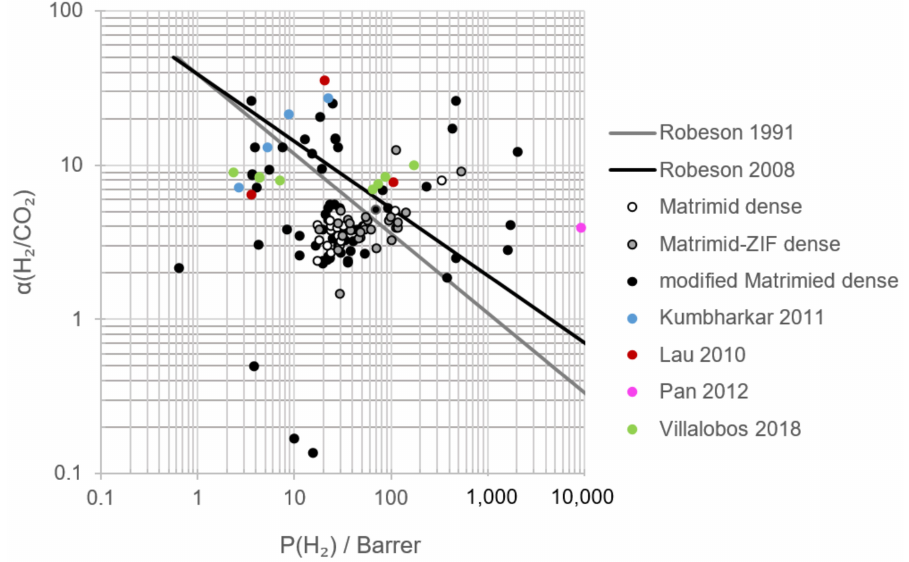
Figure 10. Robeson plot for H 2 /CO 2 permeation tests: performance comparison between HFMs and flat sheet